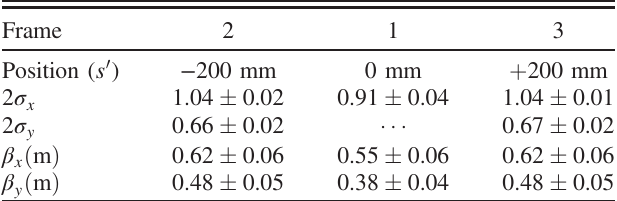
TABLE IV. Beam widths (in mm) determined at three posi- tions, center ( s 0 ¼ 0 mm) and upstream ( s 0 ¼ − 200 mm) and downstream ( s 0 ¼ þ 200 mm) ends of the PAX storage cell (see Fig. 9).